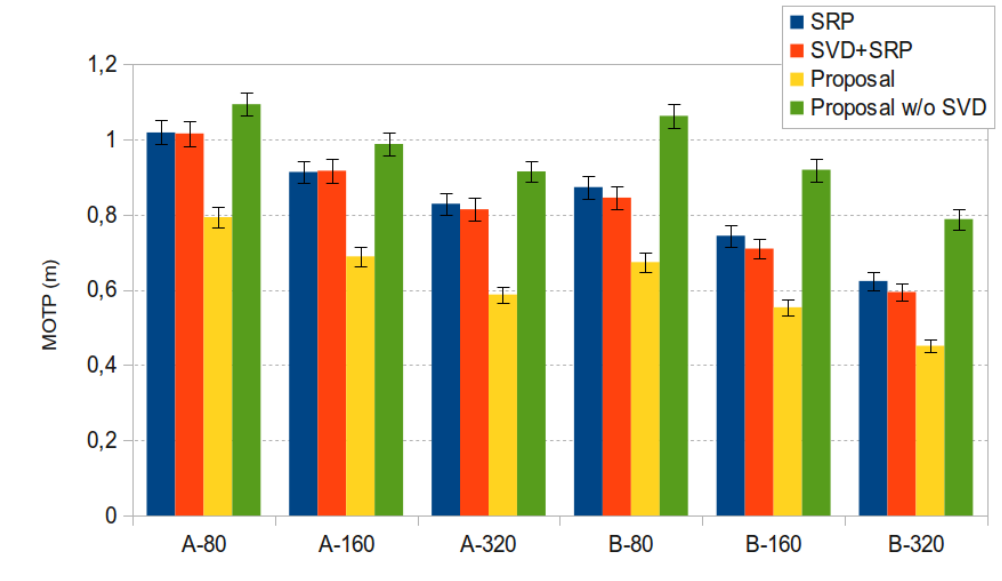
Figure 10. Best MOT P results for sequence seq01 for both microphone setups (A, B) and all frame sizes (80, 160 and 320 ms.), with 95% confidence